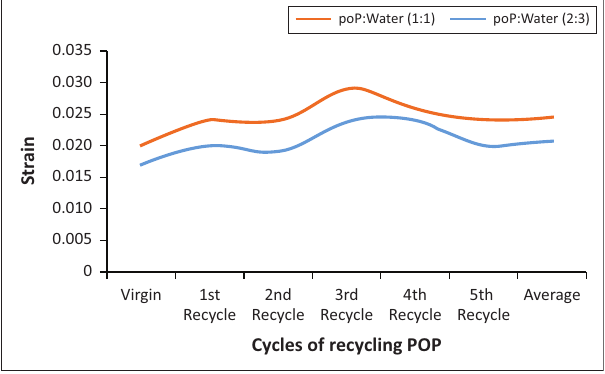
Figure 14 indicates that, the model mixed at 1:1 ratio resulted in a volume change of 2.04 % , while the model mixed at 2:3 ratio had a volume change of 2.42 % . This indicated that there was 15.70 % greater volume change with different ratio.